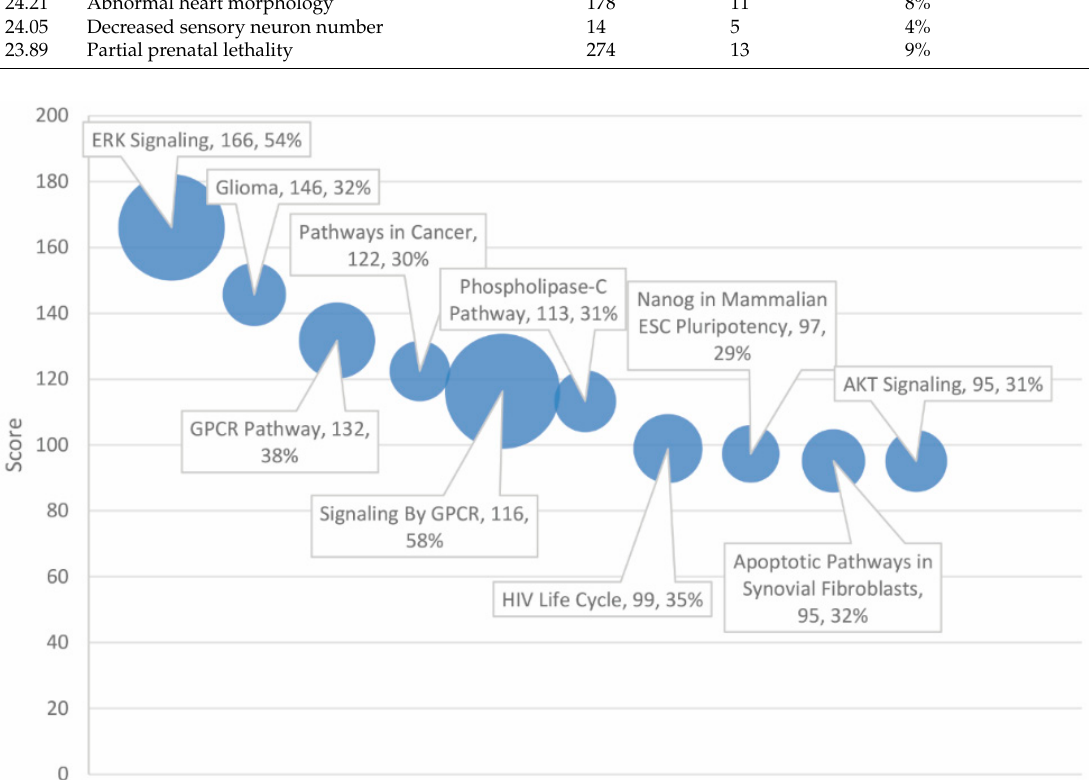
Figure 5. Pathways ranked by score and match rate (size of circle) for top ten pathways.